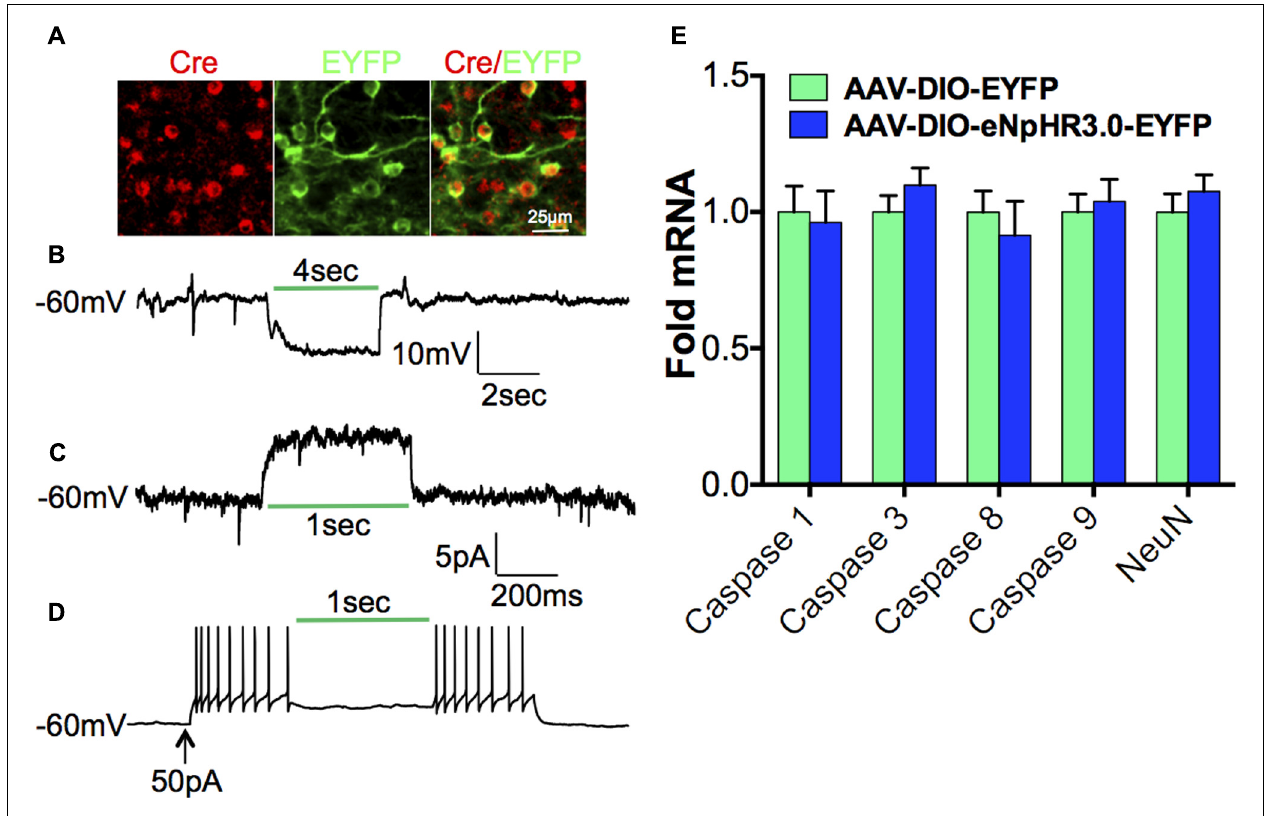
FIGURE 3 | Optogenetic inhibition of D1-MSNs. (A) Immunofluorescence image of D1-Cre NAc expressing eNpHR3.0-EYFP (green) in Cre positive D1-MSNs (red; scale bar, 25 μ m). (B) Hyperpolarization and (C) outward photo-current of the membrane potential in eNpHR3.0 expressing D1-MSNs during green (532 nm) light illumination. (D) Inhibition of neuronal firing during